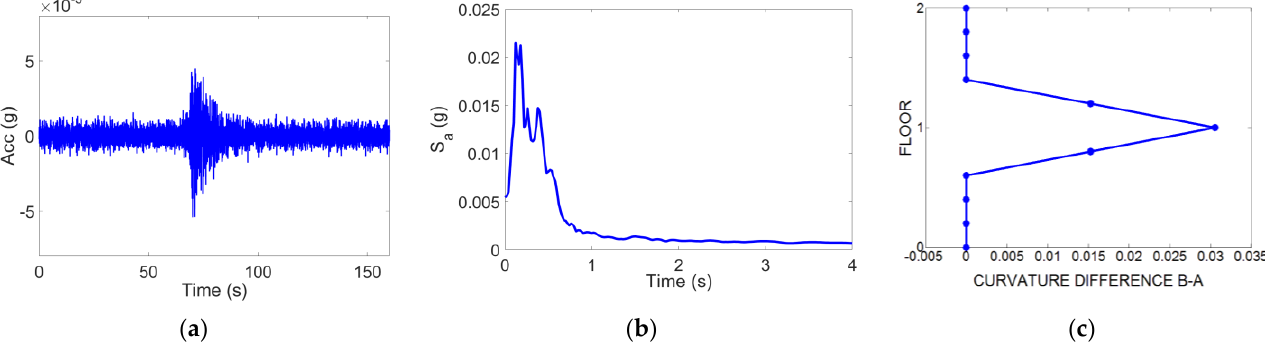
Figure 25. Results for the event that occurred on 9 April 2009 at 04:32: ( a ) ground accelerometric recordings; ( b ) response spectrum; ( c ) curvature differences between the selected time-instants B and A.